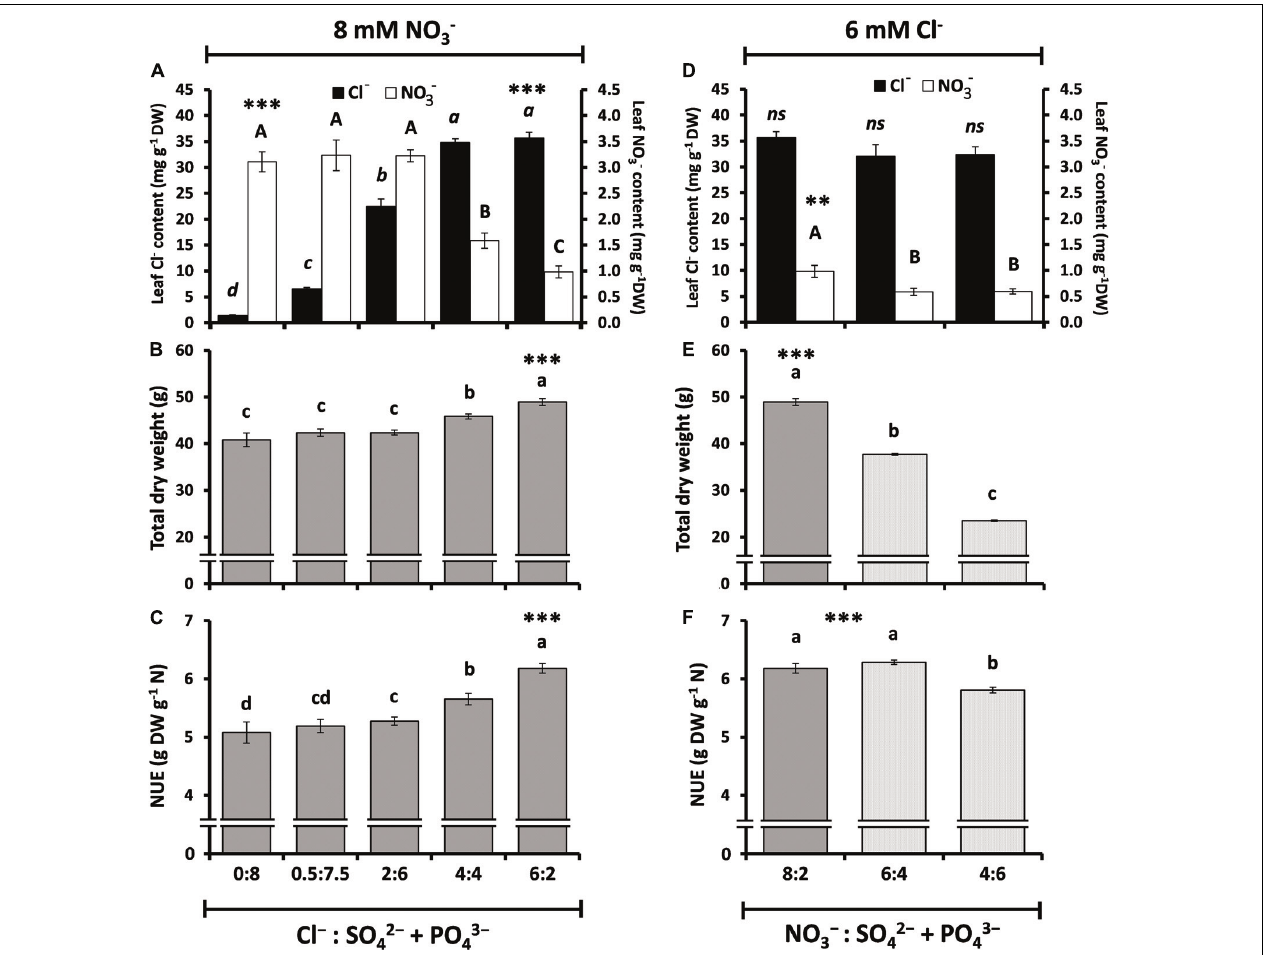
FIGURE 3 | Effect of different ratios of Cl − nutrition on anion content, plant growth, and nitrogen use efficiency (NUE) in tobacco plants. Treatments consisted of the application of: ( A–C ; ↑ Cl − / ↓ SO 42 − + PO 43 − ) increasing concentrations of Cl − (from 0.075 to 6 mM) and decreasing concentrations of SO 42 − + PO 43 − (from 8 to 2 mM) while keeping constant the concentration of NO 3 − (8 mM); and ( D–F ; ↓ NO 3 − / ↑ SO 42 − + PO 43 − ) decreasing concentrations of NO 3 − (from 8 to 4 mM) and increasing concentrations of SO 42 − + PO 43 − (from 2 to 6 mM) while keeping constant the concentration of Cl − (6 mM). (A,D) Effect on leaf anion contents (NO 3 − and Cl − ). (B,E) Effect on total dry weight (DW). (C,F) Effect on nitrogen-use efficiency (NUE). Mean values ± SE, n = 6. Levels of significance: P > 0.05 (ns, not significant differences); ∗∗∗ P ≤ 0.001; and “homogeneous group” statistics was calculated through ANOVA tests, where mean values with different letters are significantly different according toTukey’s